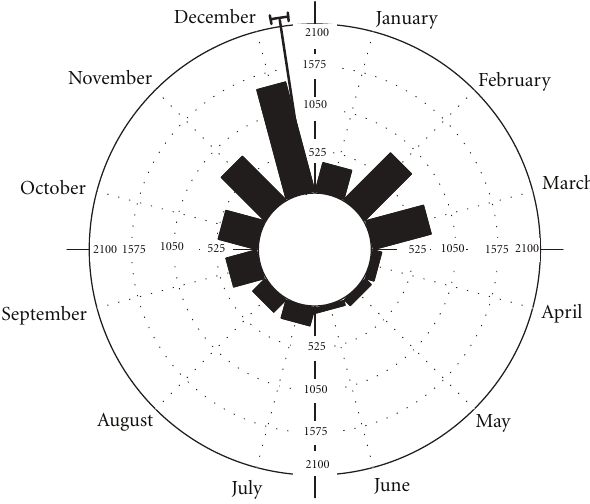
Figure 2: Circular analysis of the mean number of pollen foraging workers of Scaptotrigona a ff . depilis . Each month represents 30 ◦ of the circle, and each bar represents the number of returning pollen workers. The line at the top of the vector indicates the standard